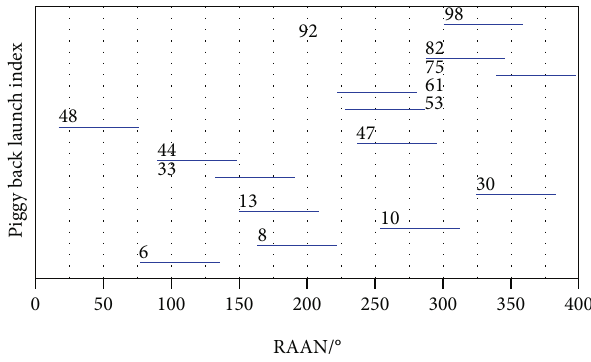
Figure 5: Accessible RAAN range of the piggyback launches that are inclined at angles of approximately 74 ° under the J perturbation.